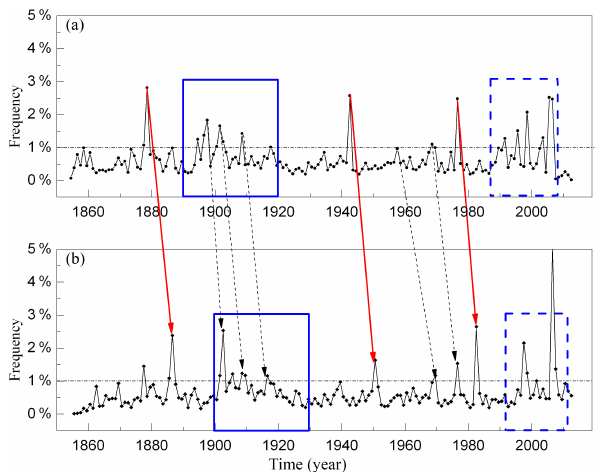
Figure 1. Frequencies of climate changes based on start mo- ments (a) and end moments (b)